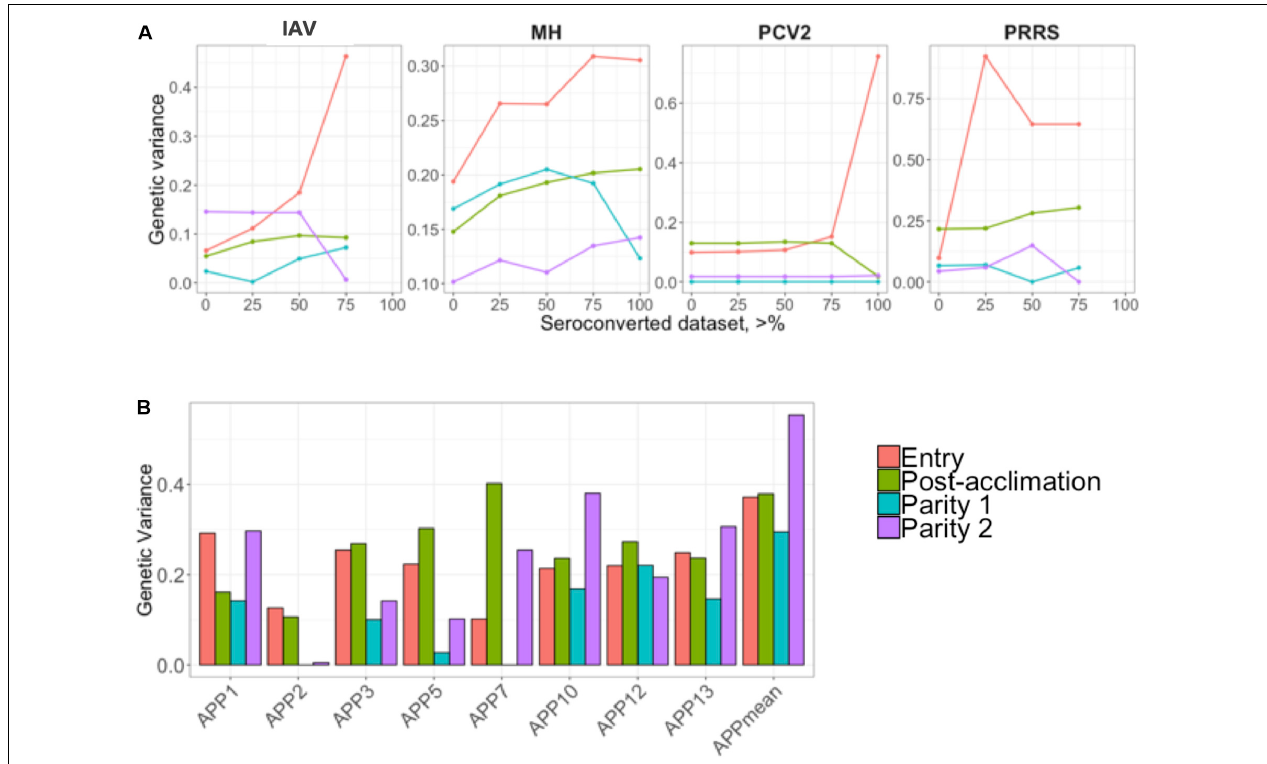
FIGURE 2 | (A) Genetic variances for the seroconverted data for influenza A virus (IAV), Mycoplasma hyopneumoniae (MH), porcine circovirus type 2 (PCV2), and Porcine Reproductive and Respiratory Syndrome (PRRS); and (B) for Actinobacillus pleuropneumoniae (APP). The y -axis represents the genetic variances, and the x -axis represents the minimum % of positive animals within a contemporary group (A) or APP (B) . APP mean represents the average of all serotypes of APP analyzed as the phenotype. The colors represent the different time-points of antibody response